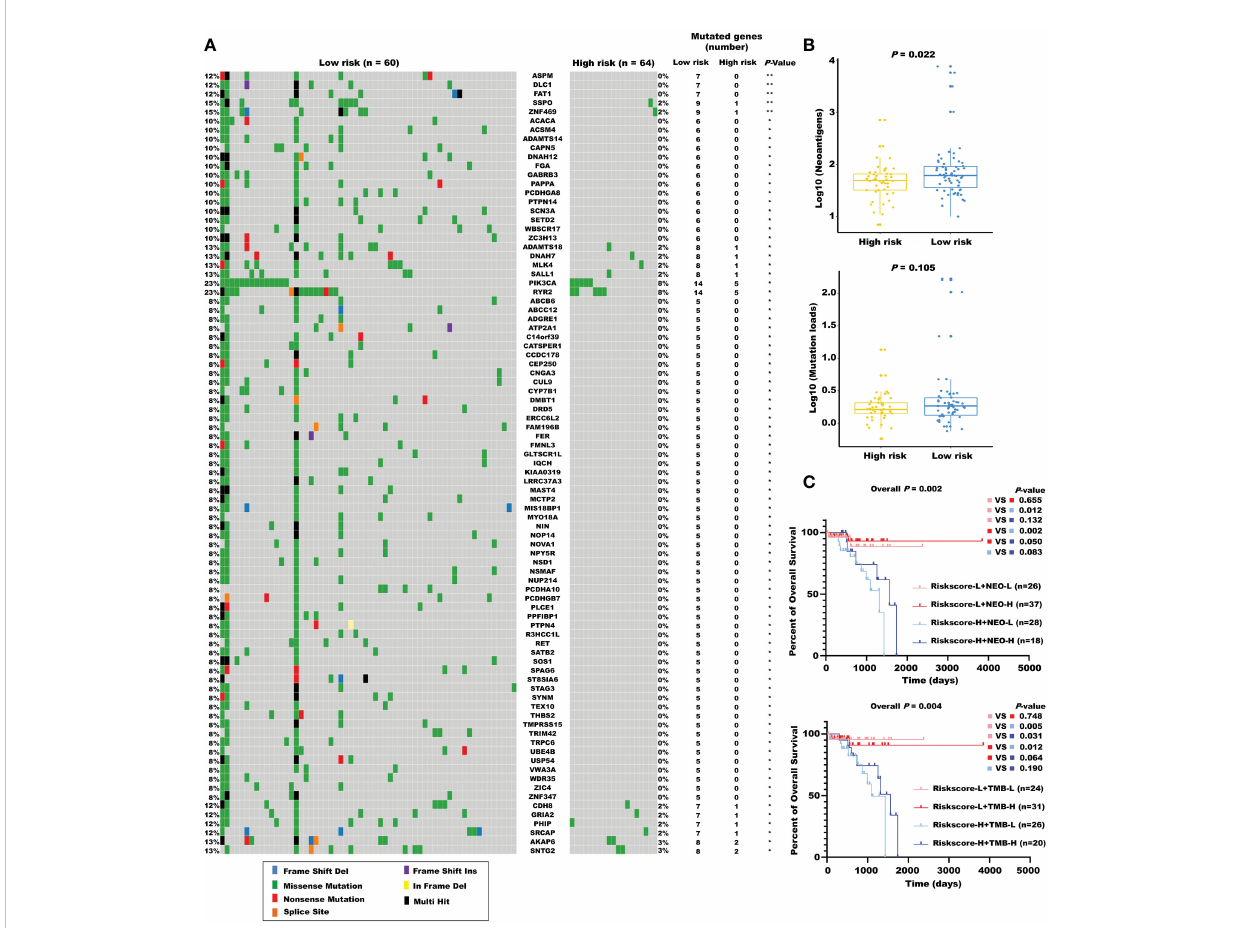
FIGURE 7 The mutational landscape for the m 5 C regulator – based signature in READ. (A) The waterfall plot of differentiated somatic mutation features between the high- and low-risk groups using the TCGA-READ data set. (B) The neoantigens and mutation loads between the two subgroups are displayed. (C) Survival analyses for READ patients strati fi ed by both the risk score and neoantigen burden or mutation loads using Kaplan – Meier curves. NEO, neoantigen burden; H, high; L, low. ** P < 0.01; * P <